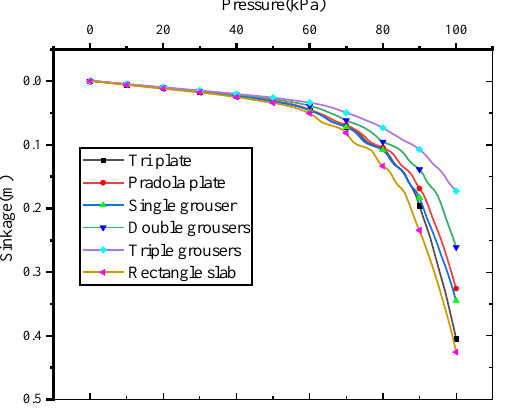
Figure 24. Pressure-sinkage curves of different grouser shapes.